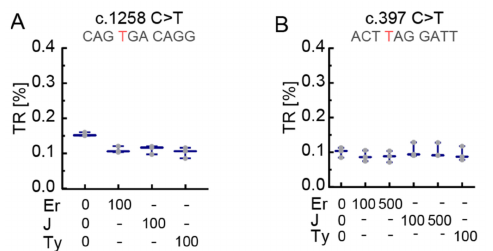
Figure 4. Absence of readthrough induction in PEX5 SCC reporters by macrolides. ( A ) In the c.1258C>T SCC, which showed highest levels of TR induction by G418 and gentamicin, neither ery- thromycin (Er), nor josamycin (J), nor tylosin (Ty) induced significant levels of TR. ( B ) Erythromycin, josamycin or tylosin at concentrations of 100 and 500 µ g/mL did not lead to significant levels of TR in c.397C>T SCC. N = 3. Concentrations in µ g/mL. Nucleotide variation resulting in PTC is shown in